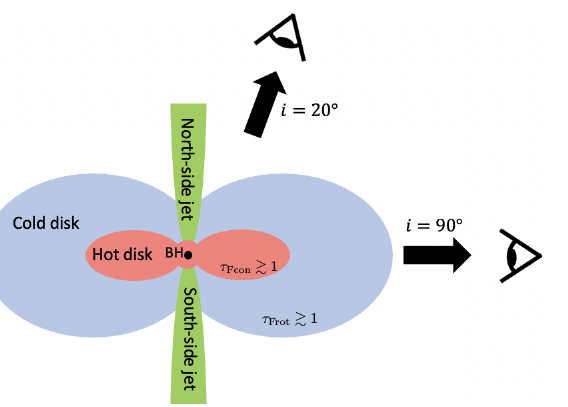
Figure 1. A schematic picture of the jet–disk structure (adopted from Tsunetoe et al. [18]). In our model, synchrotron emission is predominantly produced in the funnel jet (green). After the emission, the polarized lights experience Faraday conversion in the inner hot disk (red) and Faraday rotation in the outer cold disk (blue) on the way to the observer (eyeball), respectively. See [18] for poloidal-slice maps of typical values of the emissivity and Faraday